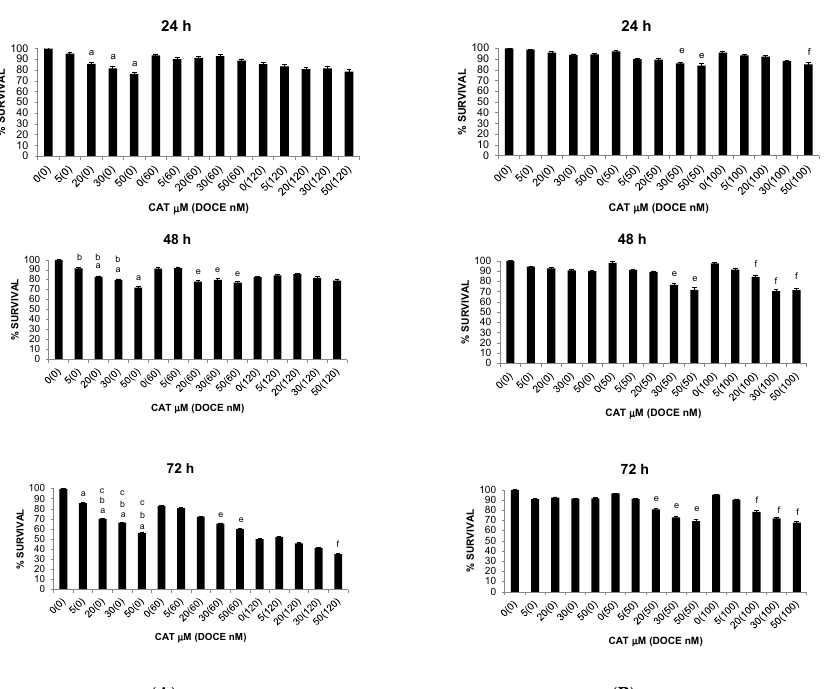
Figure 5. Trypan blue dye exclusion assay results showing viability of MCF-7 ( A ) and T47D ( B ) BC cells under different concentrations of the test compound (CAT, DOCE, CAT + DOCE) at 24 h, 48 h and 72 h. Columns, mean; bars, SE (n = 3). a represents the significant difference between CAT treatment alone and control treatment; b represents the significant difference between CAT treatment alone for 48 or 72 h and CAT treatment alone for 24 h; c represents the significant difference between CAT treatment alone for 72 h and CAT treatment alone for 48 h; e represents the significant difference between combination treatment (ProB2 + DOCE 60 Nm or DOCE 50 nM) and 60 nM DOCE or DOCE 50 nM alone; f represents the significant difference between combination treatment (ProB2 + DOCE 120 nM or DOCE 100 nM) and 120 nM DOCE or DOCE 100 nM alone ( p < 0.05; one-way ANOVA). Abbreviations: CAT, catechin; DOCE, docetaxel.